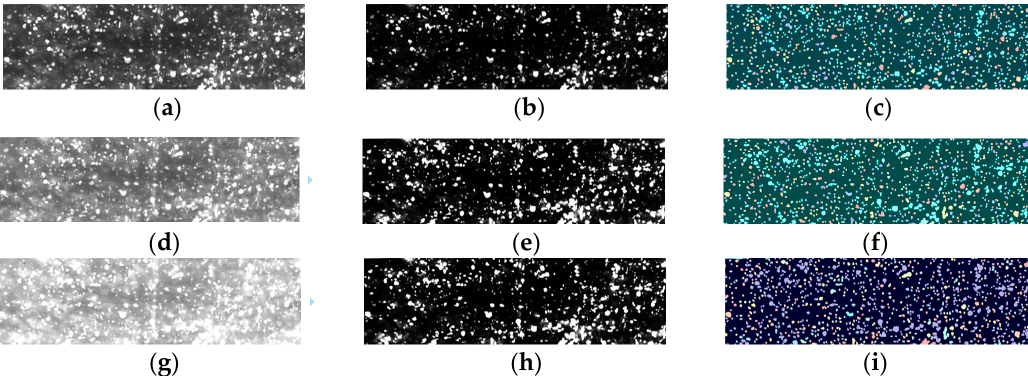
Figure 9. The results of adaptive under different illumination intensity. ( a – c ) are respectively original droplets image, optimum contrast image and segmented result within the illumination of 3.50 × 10 3 Lx; ( d – f ) are respectively original droplets image, optimum contrast image and segmented result within the illumination of 3.55 × 10 3 Lx; ( g – i ) are respectively original droplets image, optimum contrast image and segmented result within the illumination of 3.60 × 10 3 Lx.